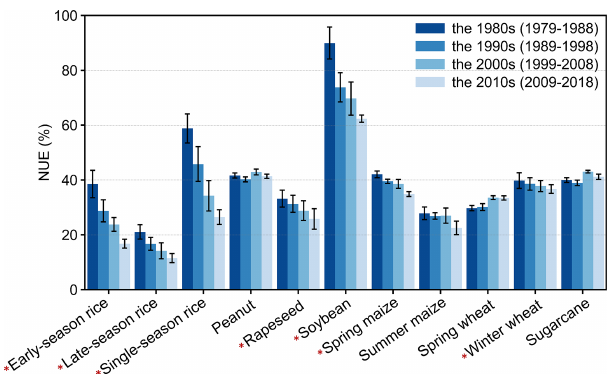
Figure 5. Decadal values of NUE for each crop functional type, averaged over the Yangtze Plain for the past 4 decades. Significantly decreasing trends ( p < 0.05) are annotated with ∗ using a t